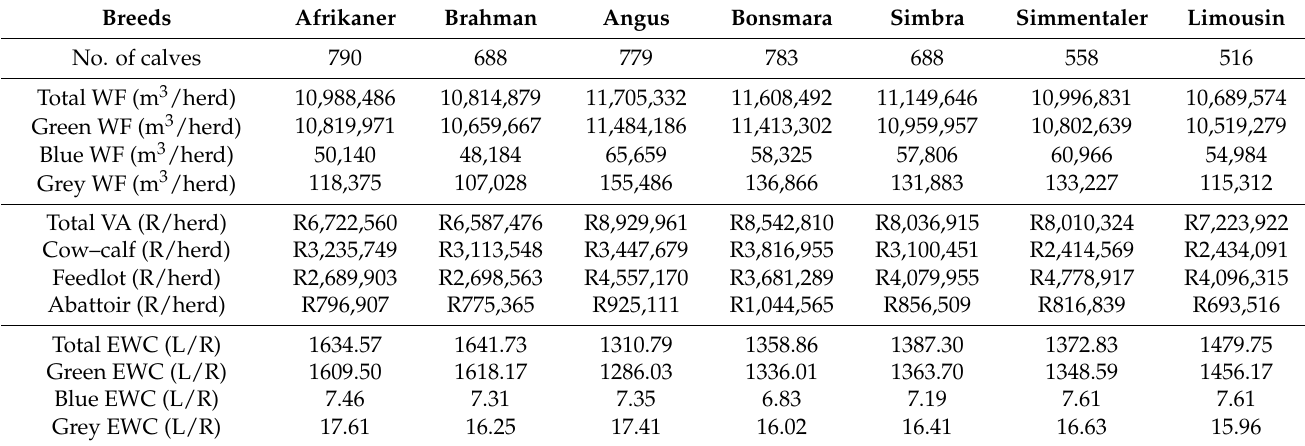
Table 4. The economic water consumption of beef produced from different cattle breeds.